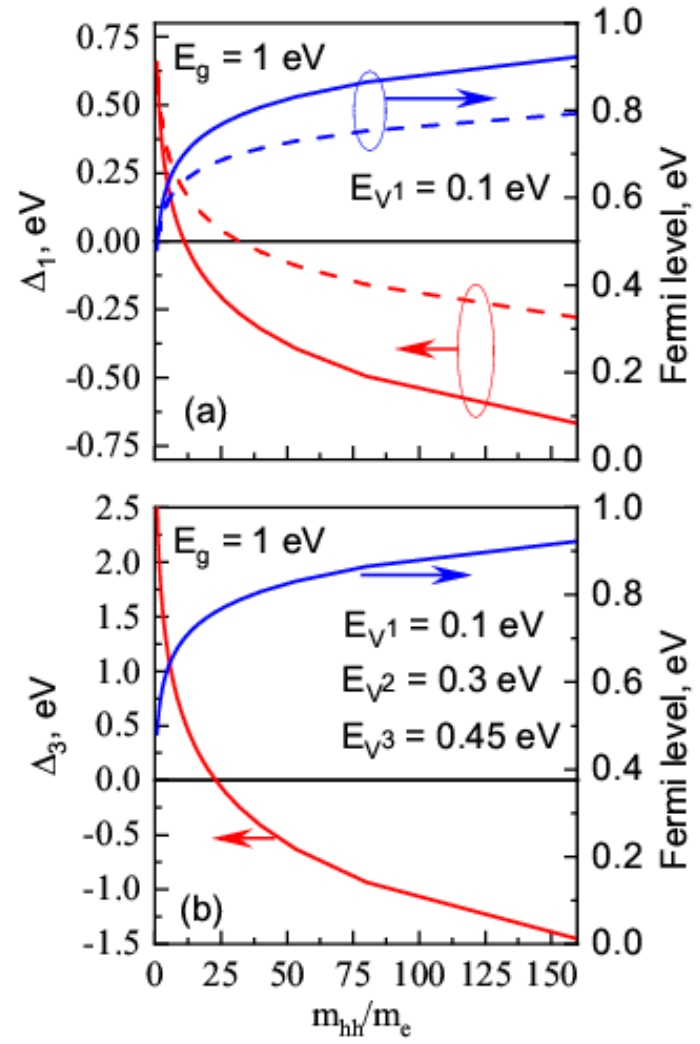
Figure 2. Factor ∆ j (red) and the Fermi-level position (blue) calculated as functions of heavy hole to effective electron mass ratio, for the material with E g = 1 eV. ( a ) Single-charged vacancy with electron ionization energy E − 1 = 0.1 eV for T = 1300 K (solid lines) and for 900 K (dashed lines); ( b ) triple-charged vacancy with the ionization energy for the first, second, and third electron, E − 1 = 0.1 eV, E − 2 = 0.3 eV, and E − 3 = 0.45 eV, respectively, for T = 1300 K.